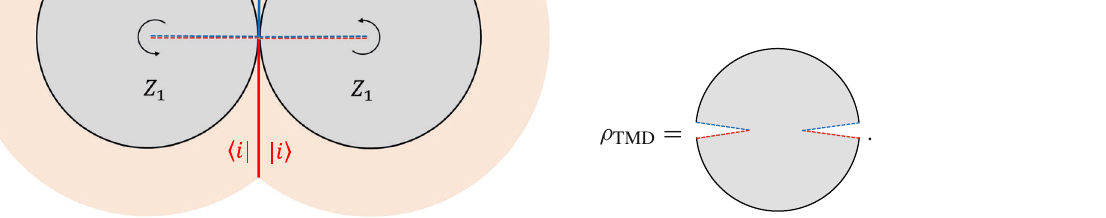
Fig. 2 Hawking saddle in calculating the purity of radiation (6). The corresponding result is